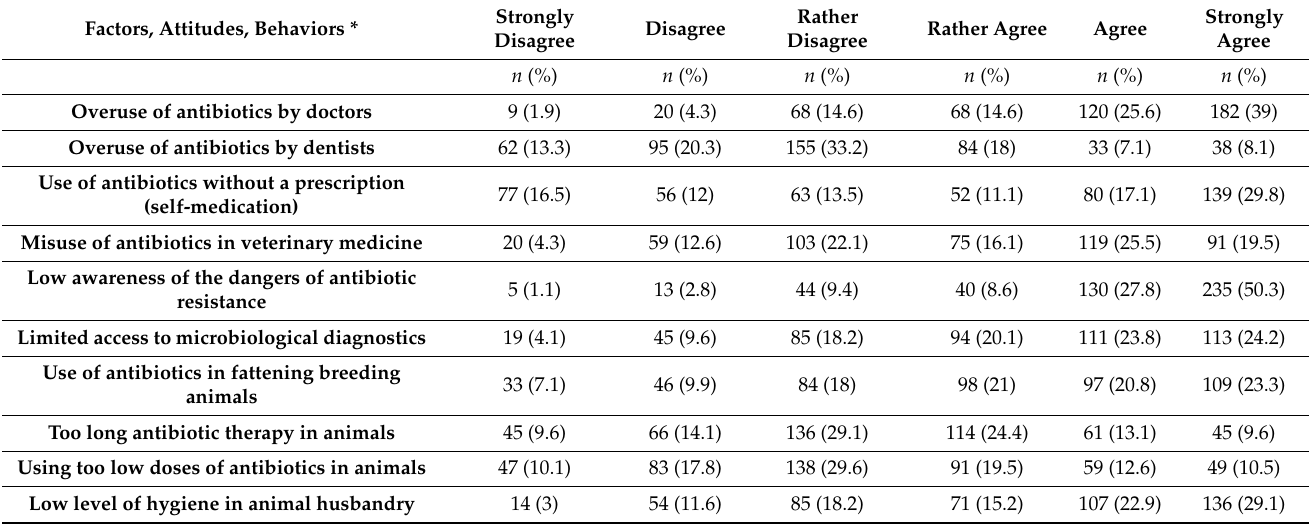
Table 6. Assessing the influence of factors on the emergence of antibiotic resistance ( n =